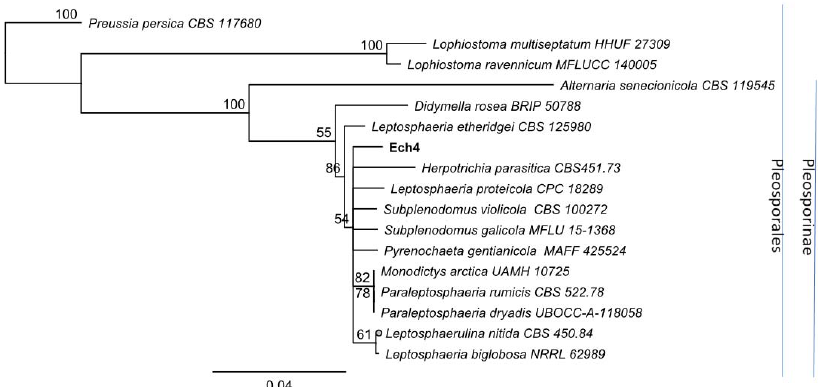
Figure 10. Neighbor-joining tree based on fungal internal transcribed spacer (ITS) sequences of Ech4 (Accession: OK090880), 15 Pleosporales species. and Preussia persica CBS 117,680 as outgroup. Numbers labeled at each node indicate bootstrap value (percentage) from 1000 replicates. Bar, 0.04 substitutions per nucleotide position.